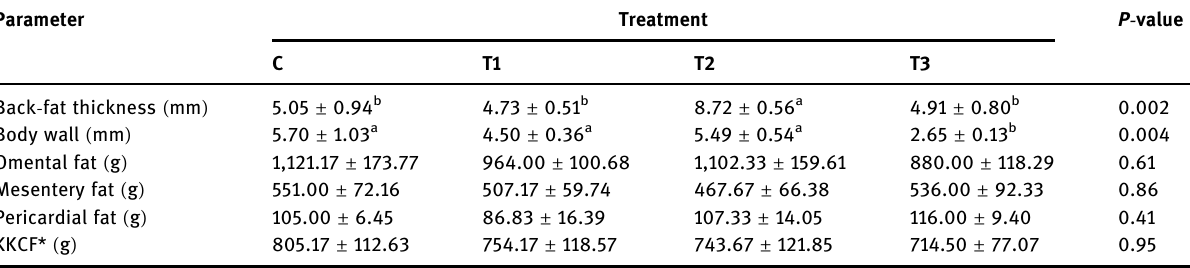
Table 13: Carcass fat deposits of DFM - o ff ered growing Najdi lambs weaned at di ff erent ages ( mean value ± SE )